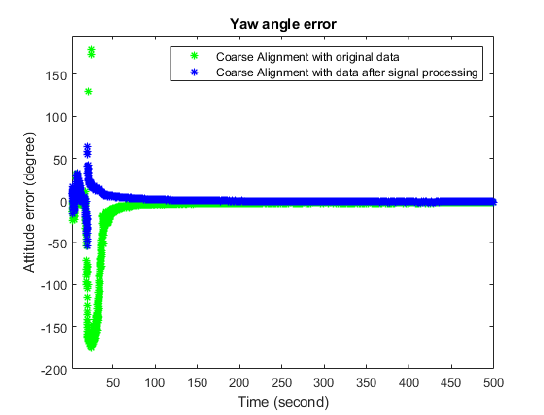
Figure 16 .Yaw angle error in coarse alignment The numerical analysis is applied to display the performance of initial alignment. From the Table 6 and Table 7 , the root-mean- square-error of yaw angles reduce about 6 times. We can recognize that after conducting signal processing and using parameters of error model from Allan variance test, the initial alignment performance of yaw angle during experiment becomes better.